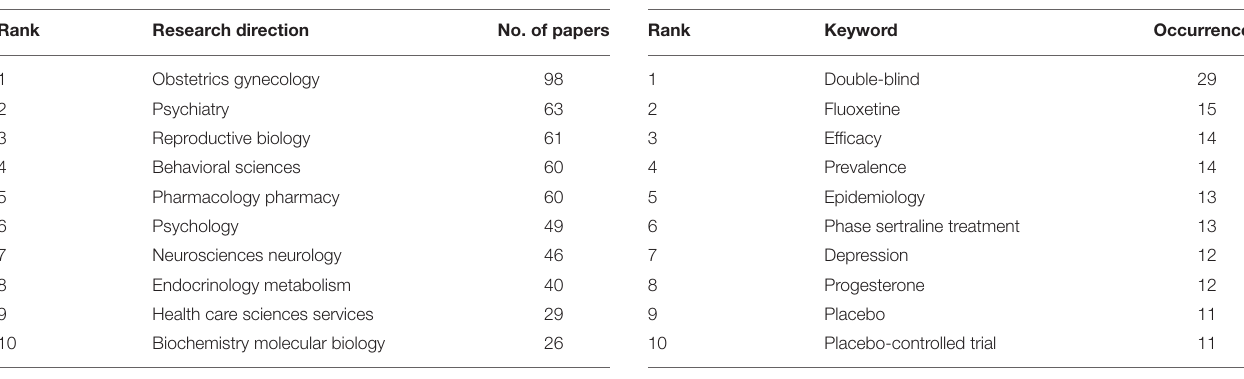
TABLE 3 | Top 10 Co-occurring Keywords in the Top 100 cited papers on